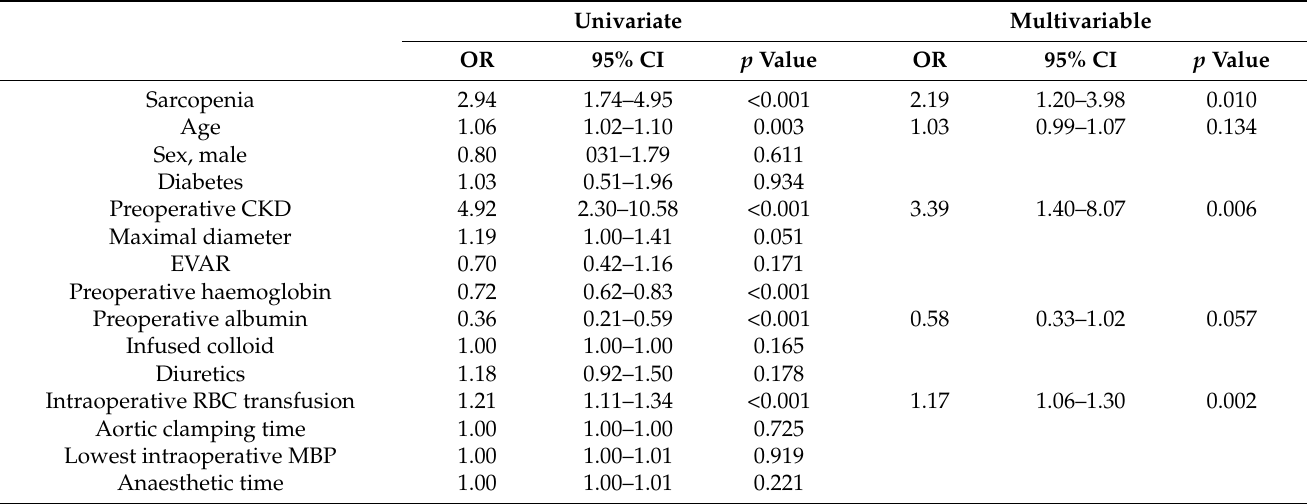
Table 2. Multivariable analysis of risk factors associated with acute kidney injury. Univariate